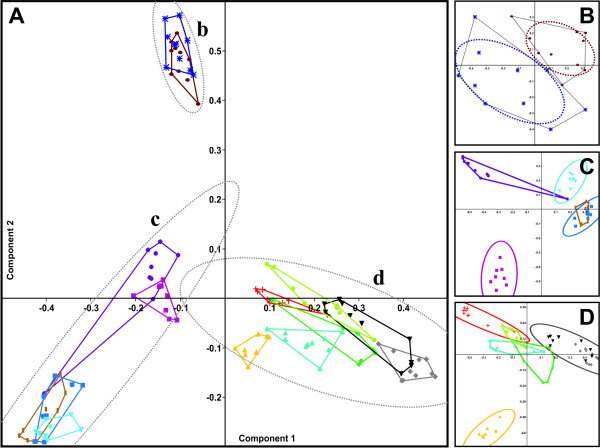
Scatterplots from unbiased PCAs using 125 spectra from flies of 13 different species. Species-specific color-coding corresponds to that shown in Fig. 2. Spectra belonging to one species are outlined by a convex shape or an ellipse. A: PCA containing all spectra, with 95% concentration ellipses for three subgenera/species groups. B: PCA using only spectra from D. pseudoobscura and D. miranda, with 50% concentration ellipses. C: PCA performed with spectra from the subgenus Drosophila but without D. pseudoobscura and D. miranda, with 95% concentration ellipses. D: PCA of the spectra from the subgenus Sophophora, with 95% concentration ellipses.